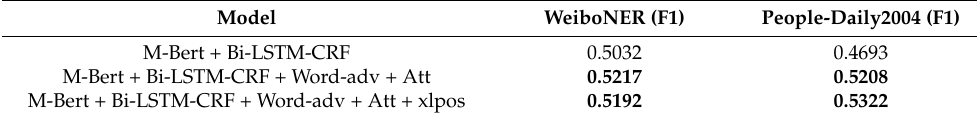
Table 4. Comparison of the effects of different models on two Chinese